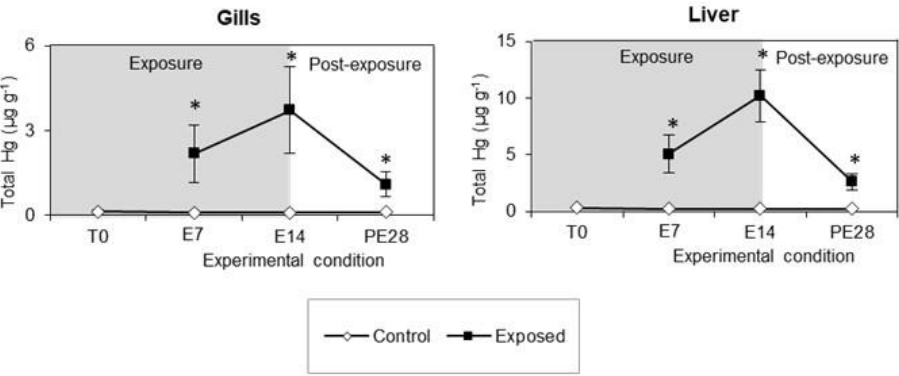
Figure 2. Total Hg level (tHg; µ g g − 1 ) measured in the gills and liver of white seabream exposed to MeHg and in control fish at each experimental time over 14 days of exposure (7 and 14 days, corresponding to E7 and E14) and 28 days of post-exposure (day 42, corresponding to PE28). Data correspond to mean ± standard deviation (n = 8). Significant differences (Sidak’s test; p < 0.05) in relation to the control group are indicated by * for each experimental time.